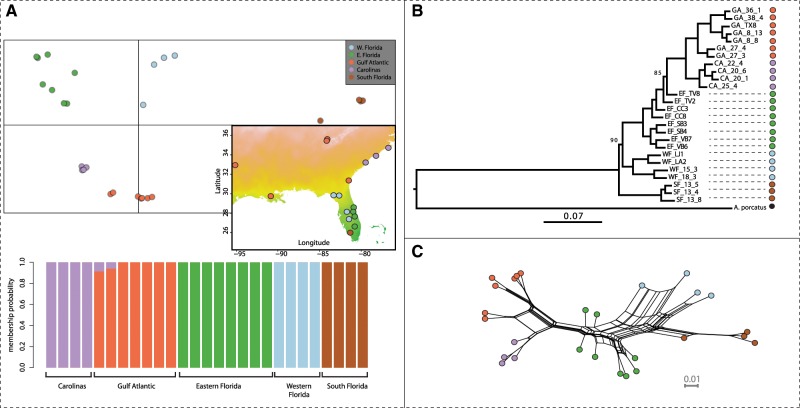
—Genetic structure in Anolis carolinensis from whole-genome SNP data. (A) Results from the DAPC analysis highlighting the five clusters inferred from the analysis of ∼6,500 SNPs thinned every 10 kb and with <20% missing data. The map reports the coordinates of the localities used in this study and the genetic clusters they belong to. (B) RAxML phylogeny based on one million SNPs randomly sampled across the genome. All 100 bootstrap replicates supported the reported topology, except for two nodes with support of 90 and 85. One individual from South Florida was removed due to a high rate of missing data. (C) Network representation of the relatedness between samples as inferred by Splitstree v4. Color codes match those in parts (A) and (B).